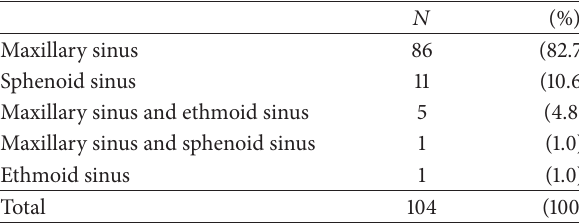
Table 3: Paranasal sinus localizations.